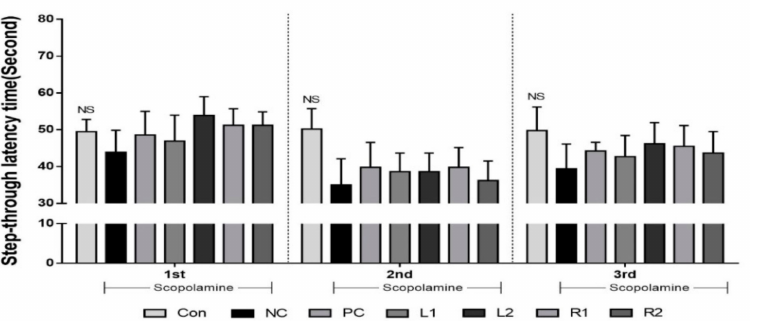
Figure 3. Effects of Allium hookeri leaf and root extracts on the step-through latency time during the passive avoidance test of C57BL/6 mice with memory impairment induced by scopolamine. The passive avoidance test was conducted after 1 week of training. All values are expressed as the mean ± SEM ( n = 7). NS Not significantly different among